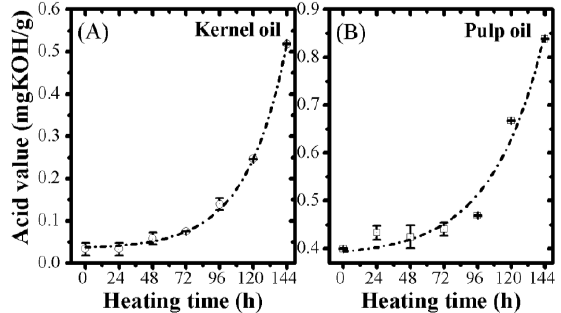
Figure 6. Acid value as a function of heating time: ( A ) kernel oil and ( B ) pulp oil.